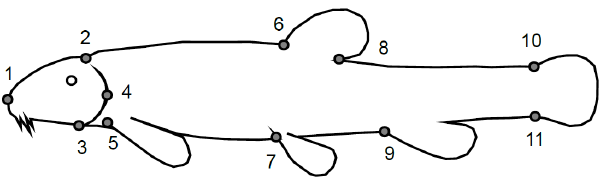
Figure 2. Sabanejewia body with 11 landmarks (middle)—1. Tip of snout, 2. Forehead (end of frontal bone), 3. End of operculum (ventral part), 4. End of the operculum (lateral), 5. Dorsal origin of pectoral fin, 6. Origin of dorsal fin, 7. Origin of ventral fin, 8. Termination of dorsal fin, 9. Origin of anal fin, 10. Base of caudal fin (dorsal), 11. Base of caudal fin (ventral).